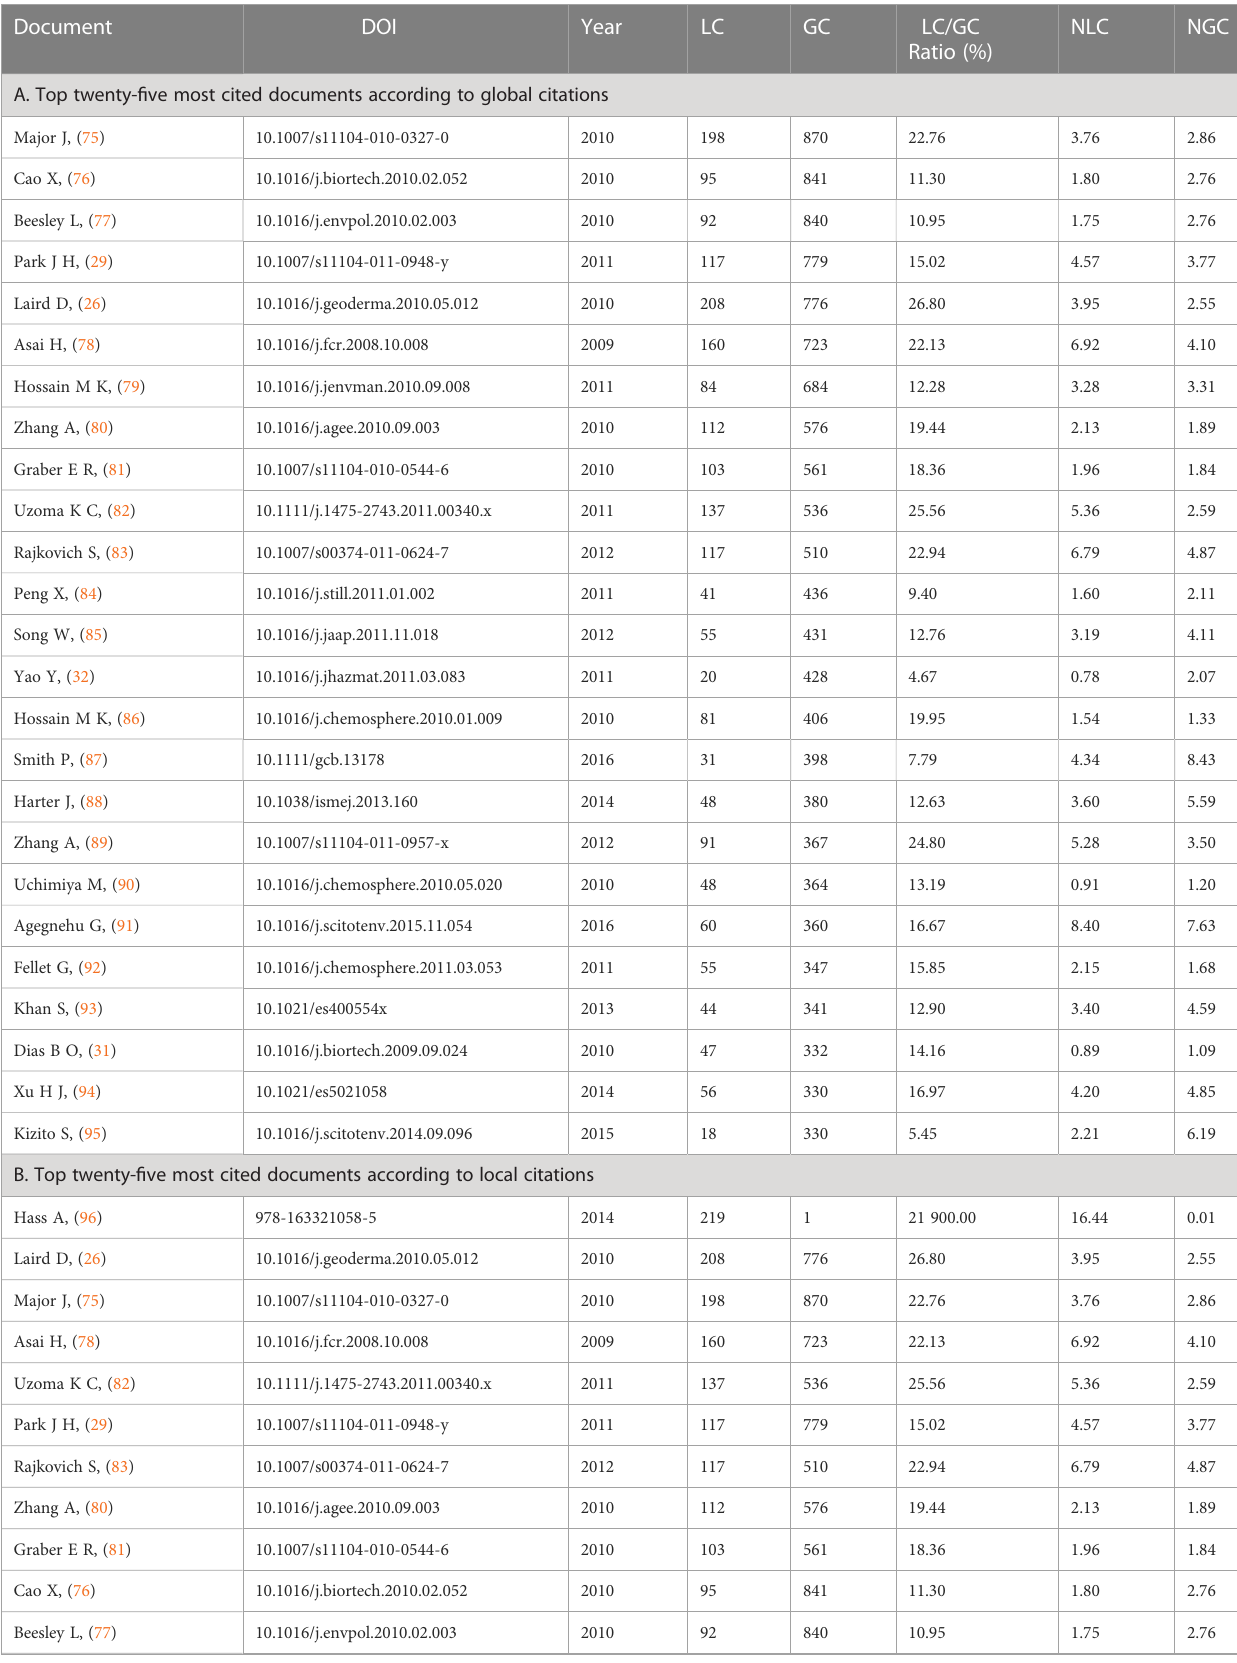
TABLE 4 Top twenty- fi ve most cited documents on biochar-based smart fertilizers according to global citations ( A ) and local citations ( B ). Document DOI Year